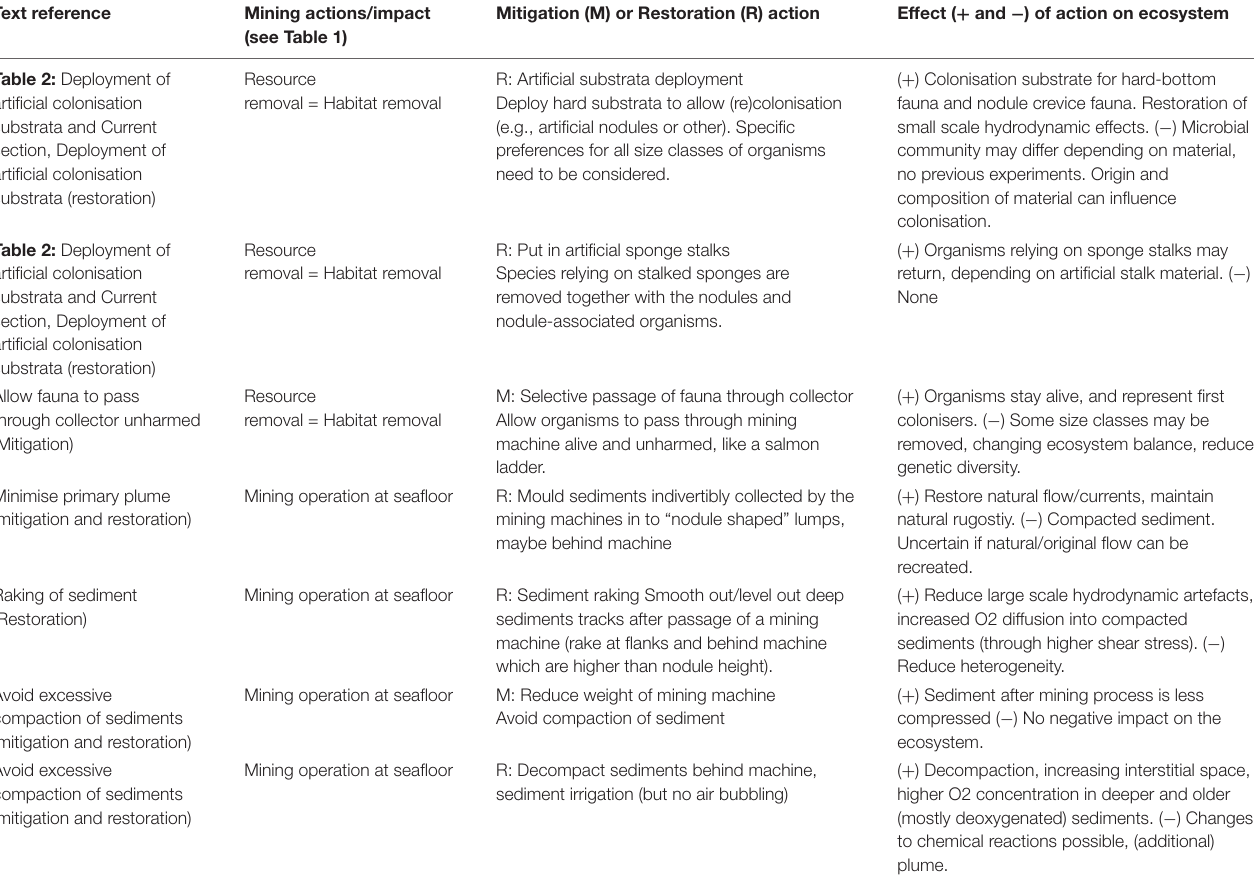
TABLE 5 | Proposed mitigation and restoration actions specifically for Mn nodule mining at abyssal plains.